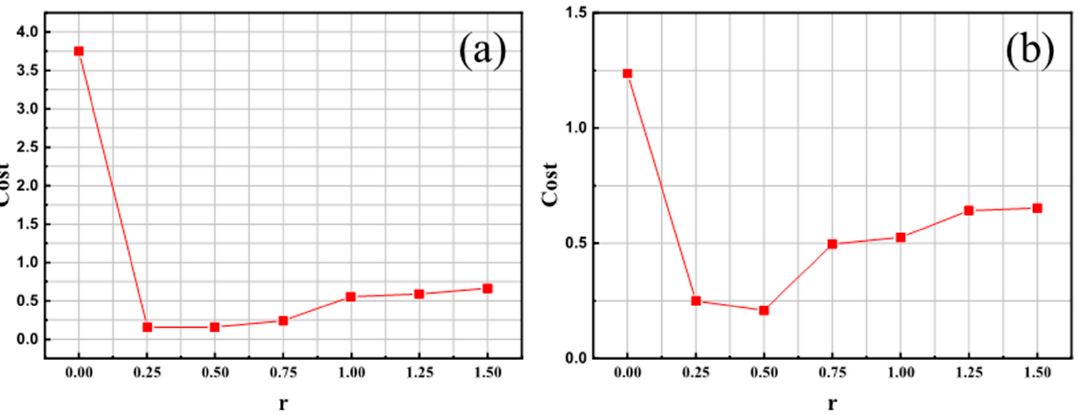
Figure 7. ( a ) Cost (×10 − 3 ) with varying weight ratios on NEU ( b ) Cost (×10 − 3 ) with varying weight ratios on Paint. ratios on